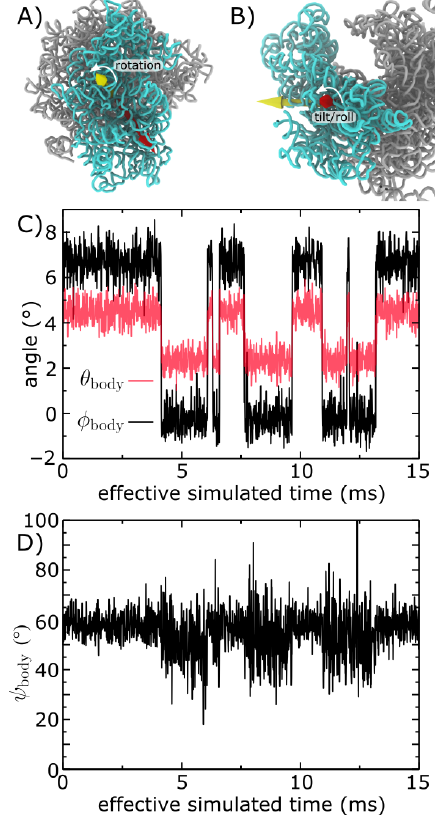
Figure 2. Simulations of subunit rotation in a eukaryotic ribosome. Using an all-atom structure-based model [28], we simulated spontaneous rotation and backrotation of the SSU in yeast. ( A ) Euler angle decomposition was used to describe the orientation of the SSU, where the angle φ body measures rotation of the SSU body, relative to the LSU. φ body is defined as rotation about the yellow vector. ( B ) The tilt angle θ body describes rotation that is orthogonal to the body rotation angle φ body . The tilt axis (red) may be in any direction perpendicular to the rotation axis (yellow), where the direction of the tilting axis is given by ψ body . In the figure, ψ body ∼ 60 ◦ is shown. ( C ) φ body and θ body shown for a single simulation (of 3, in total). In this model, there are distinct and sharp transitions between the unrotated ( φ body ∼ − 1 ◦ ) and rotated ( φ body ∼ 7 ◦ ) orientations. There are also concommittent changes in θ body . For reference, the cryo-EM structures [18] correspond to φ body ∼ − 1.8 ◦ and θ body ∼ 2.4 ◦ for the unrotated state and ∼ 8.6 ◦ and θ body ∼ 5.0 ◦ for the rotated state. Negative and non-zero angles for the unrotated conformation reflect the orientation of the SSU in yeast, relative to the reference bacterial system ( E. coli ). ( D ) In the simulation, the direction of tilting ( ψ body ) shifts to slightly higher values as the SSU rotates and tilts. This reveals how the direction of structural fluctuations depends on the global conformation of the ribosome. The effective simulated times are estimated based on previous comparisons with explicit-solvent simulations